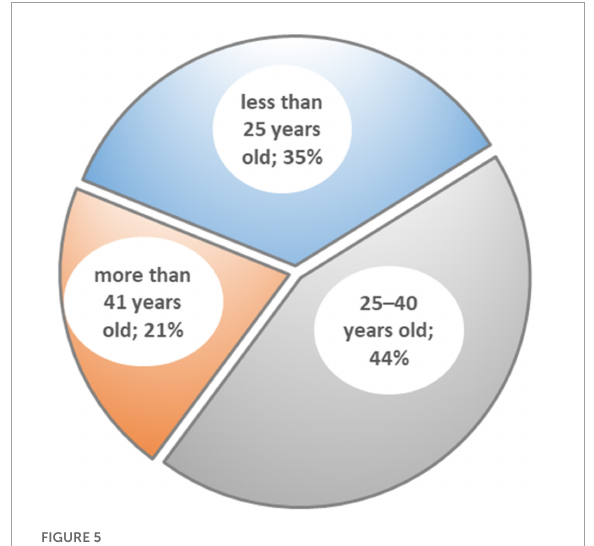
FIGURE5 Age distribution of the 425